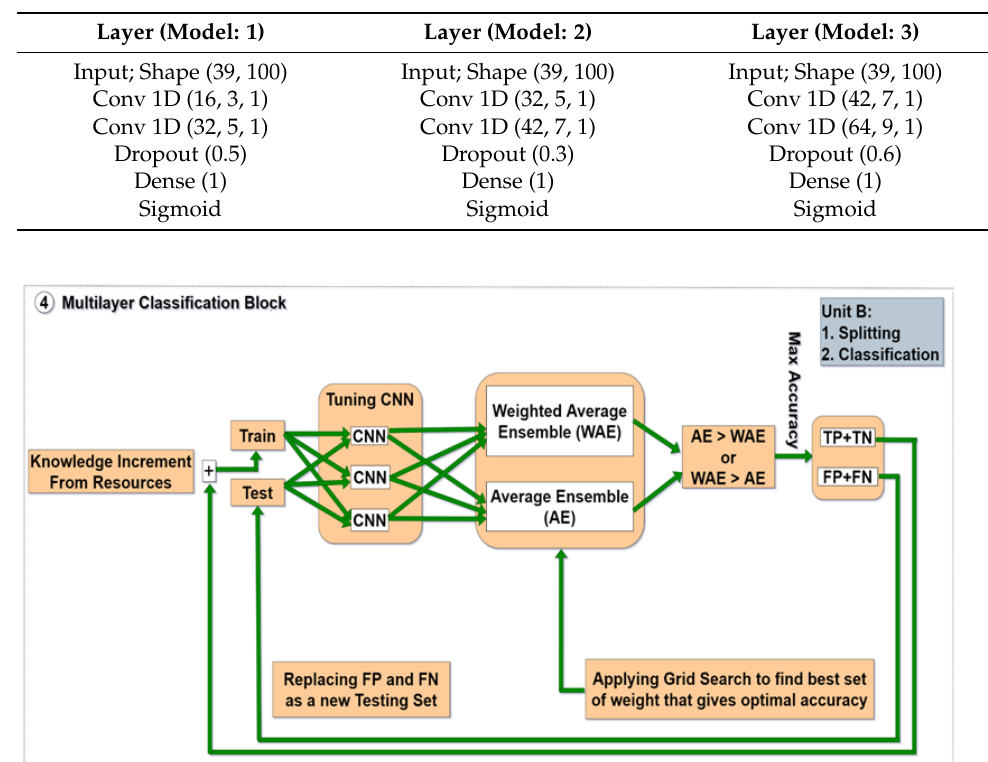
Table 5. The detailed architecture of the proposed CNN.